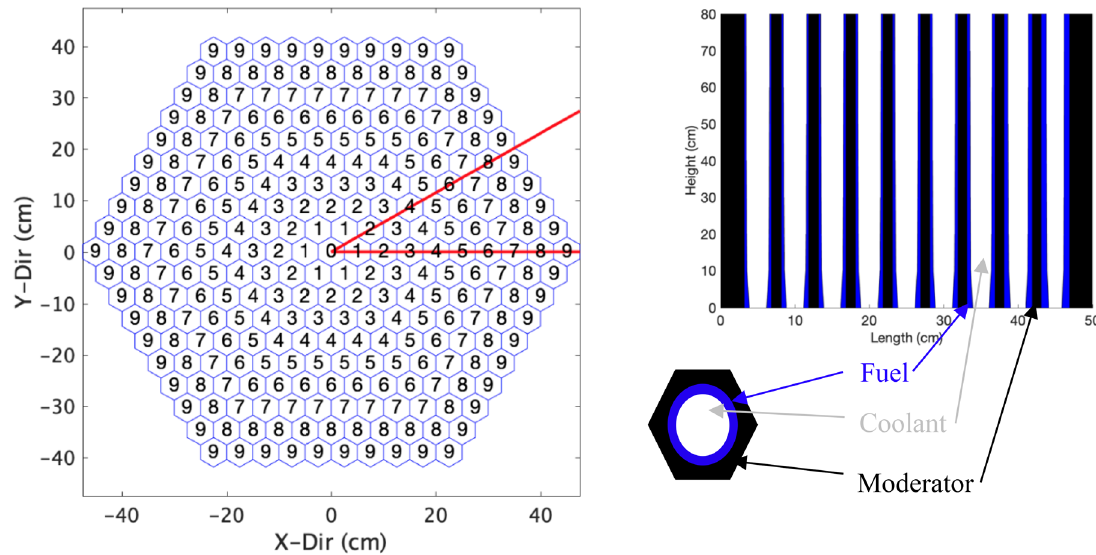
Figure 1. The top view of the core is shown on the left with the nine radial assembly rings labeled. Only the symmetric 1/12 segment inside the red lines is modeled. A horizontal slice of one assembly and an axial cross section of the optimized core configuration is shown on the right. Created using MATLAB R2020b, www. mathw orks.